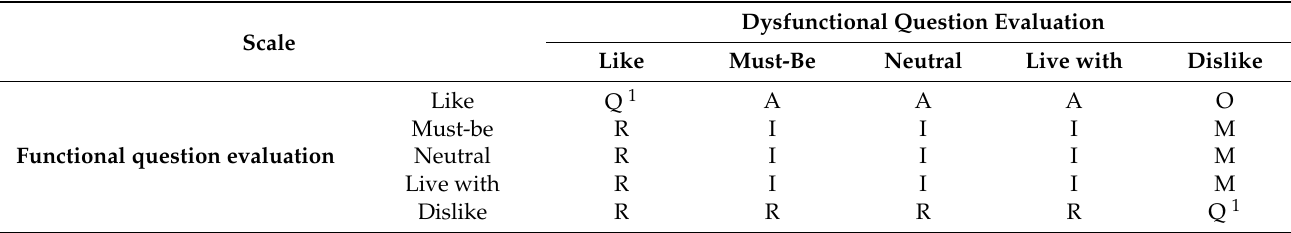
Table 5. Dysfunctional and functional questions